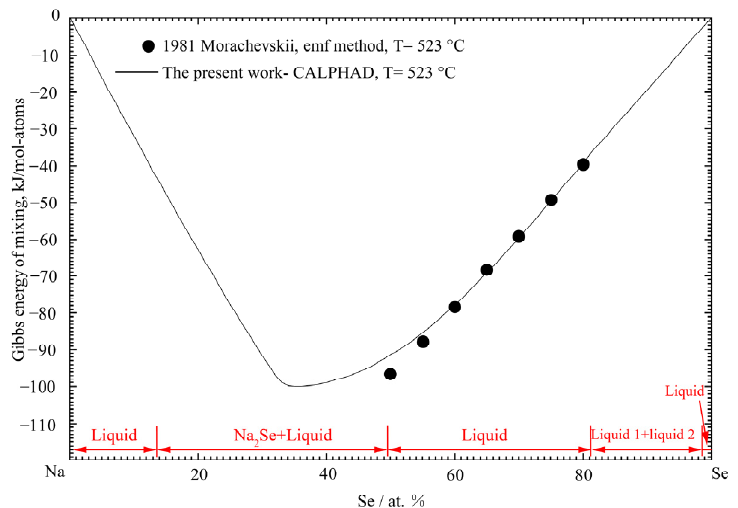
Figure 9. The calculated Gibbs energy of mixing for the liquid phase of the Na-Se binary system at 523 °C compared with the previously calculated result by Romanchenko [71].